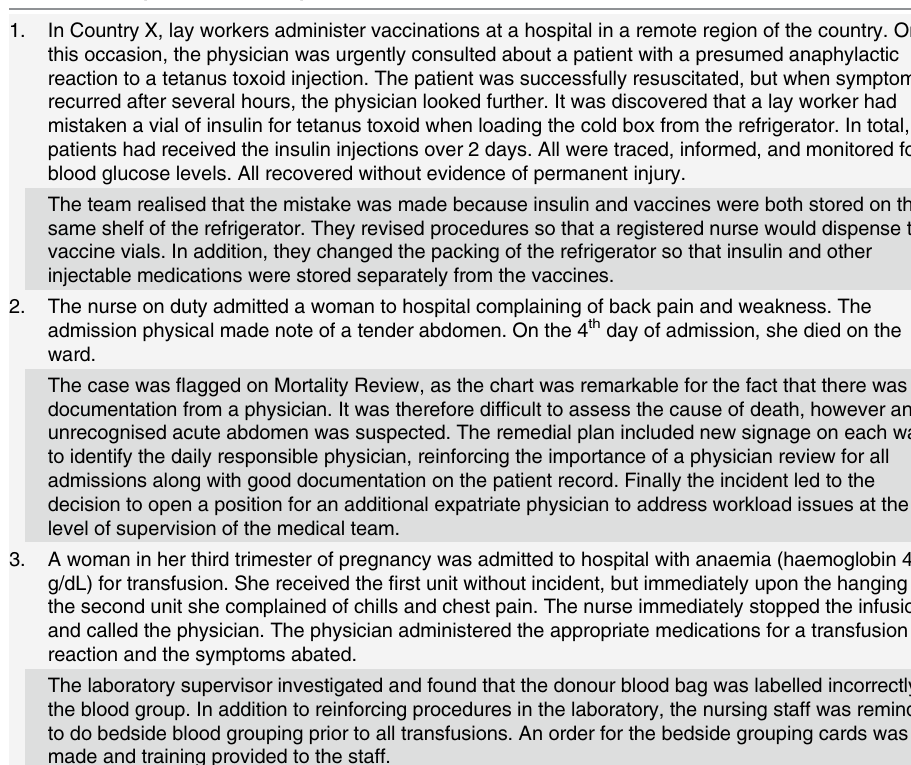
Table 6. Examples of Errors